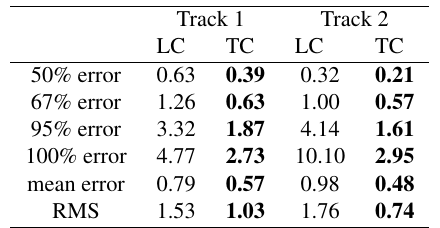
Figure 9: Track 2 CDFs of LC and TC integrated navigation results. (a) CDFs of all positioning results; (b) CDFs of only kinematic phase, static positioning points are excluded. points, this table reflects the integrated navigation performances on sheltered conditions.